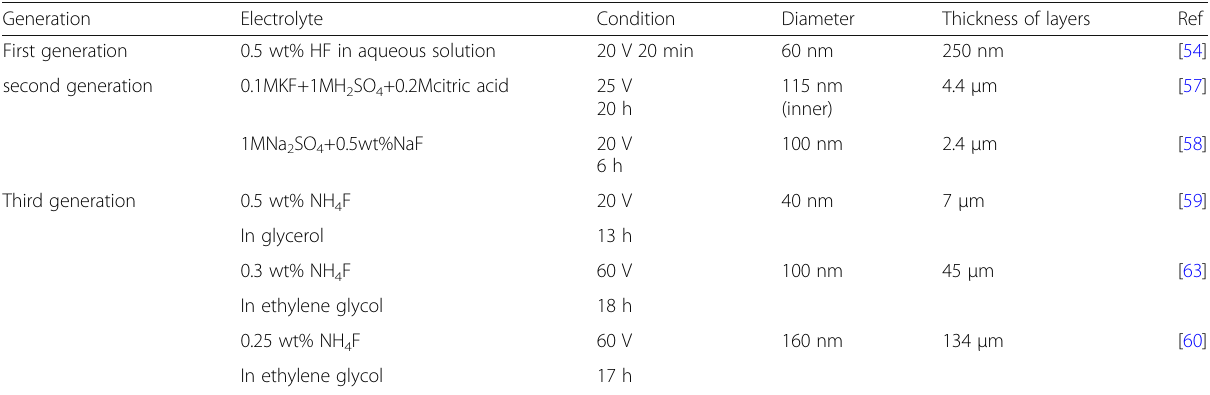
Table 1 TiO 2 nanotubes arrays fabricated through anodic oxidation in the three generations: electrolyte compositions, anodization conditions, and size of the resulting nanotubes Generation Electrolyte